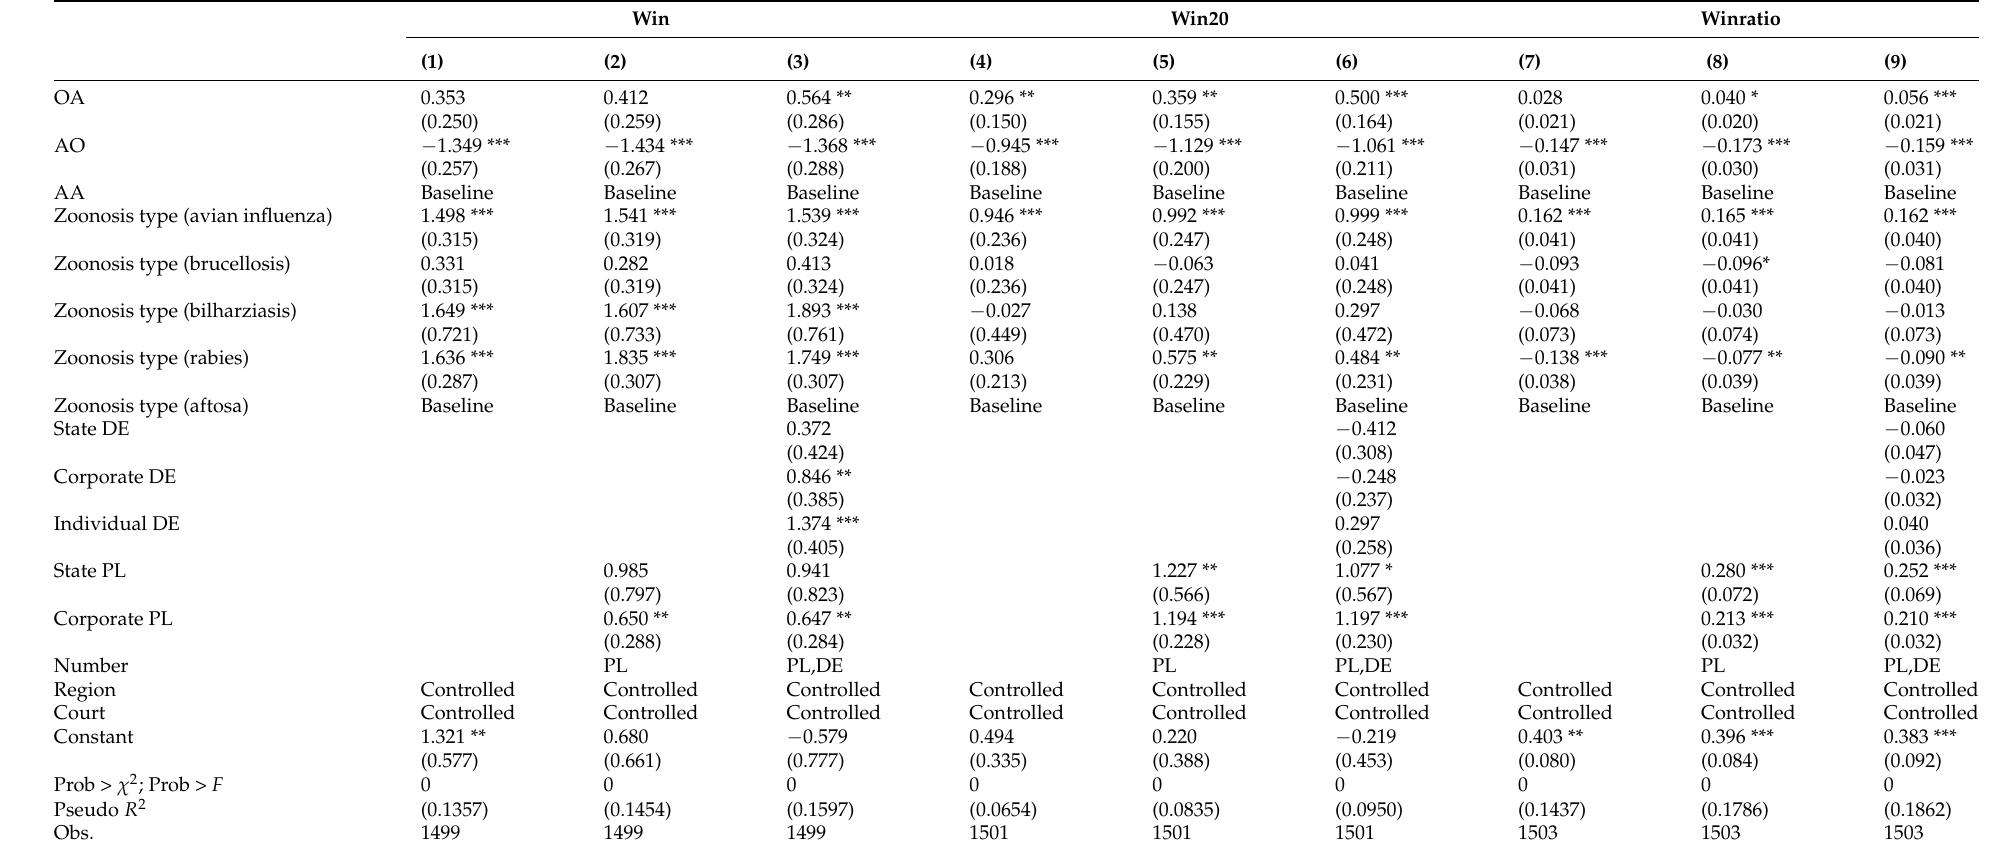
Table A2. Empirical findings from the Logit estimations and ordinary least squares (OLS)